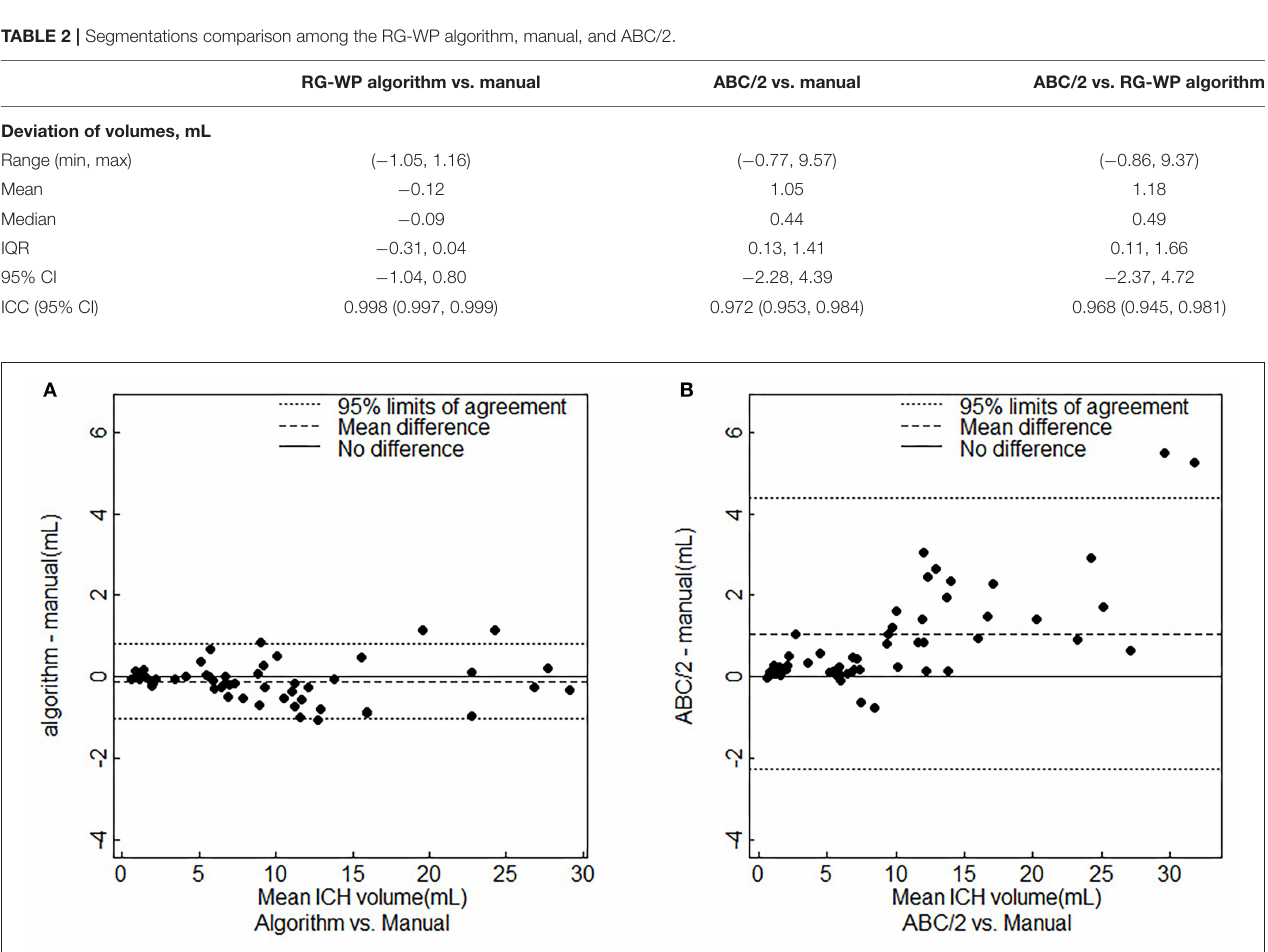
FIGURE 6 | Bland-Altman plots for agreement analysis. (A) RG-WP algorithm vs. manual segmentations. (B) ABC/2 vs. manual segmentations. ICH, intracerebral